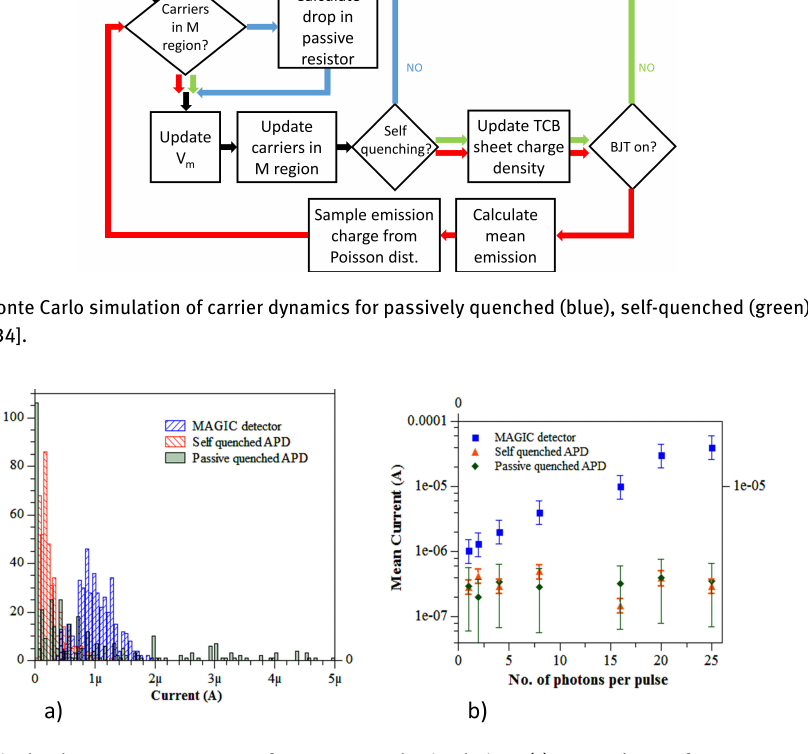
Figure 15: Distribution of single-photon current response from Monte Carlo simulations (a). Dependence of current output on the number of photons in the input signal (b). The MAGIC detector shows a dynamic range of 25 photons or more whereas passive quenched and self- quenched SPADs show no dynamic range to resolve photon numbers. From